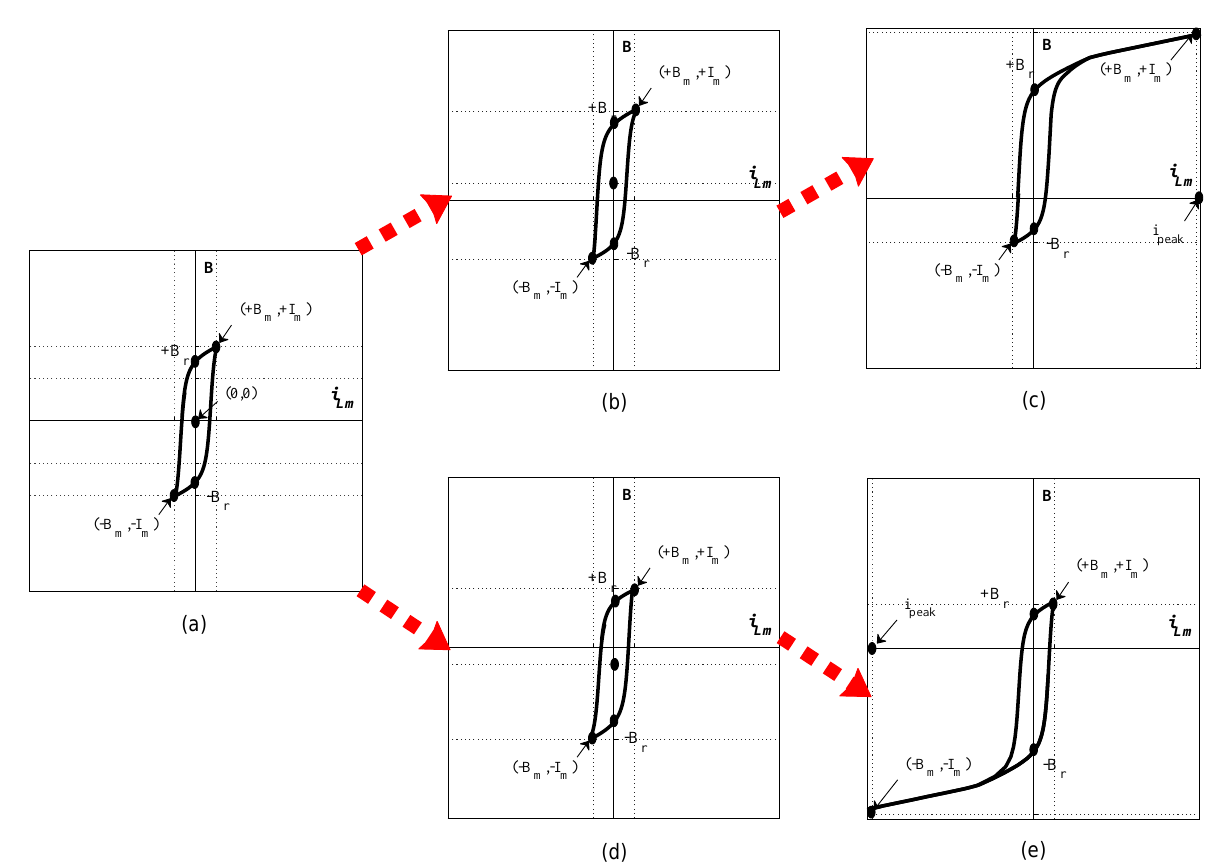
Figure 5. The B − i Lm curves: ( a ) No DC Bias. ( b ) Positive DC Bias. ( c ) Positive Saturation. ( d ) Negative DC Bias. ( e ) Negative